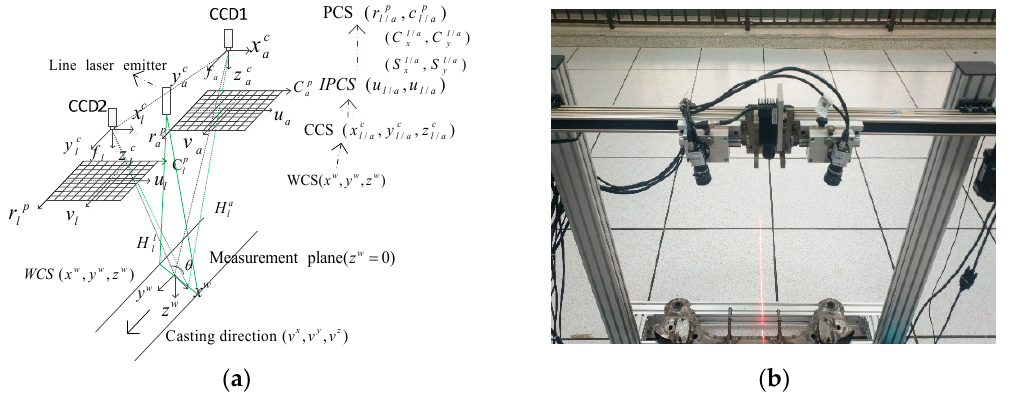
Figure 5. The schematic illustration of the binocular CCD laser image scanning system. ( a ) The schematic working principle diagram; ( b ) The corresponding devised experimental system.